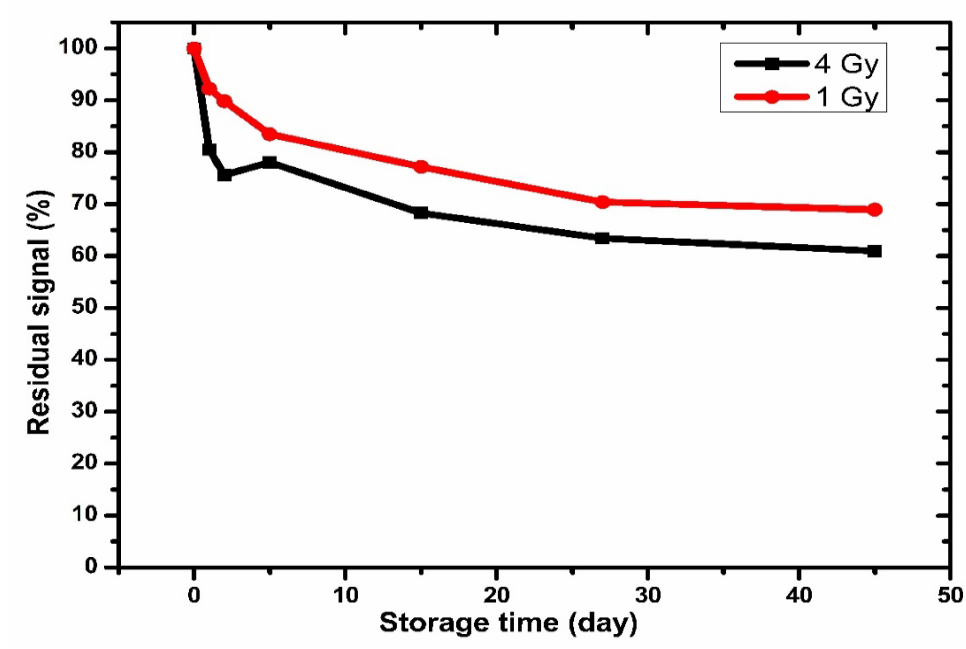
Figure 15. Thermal fading characteristics of Ag-doped ZnO thin films exposed to